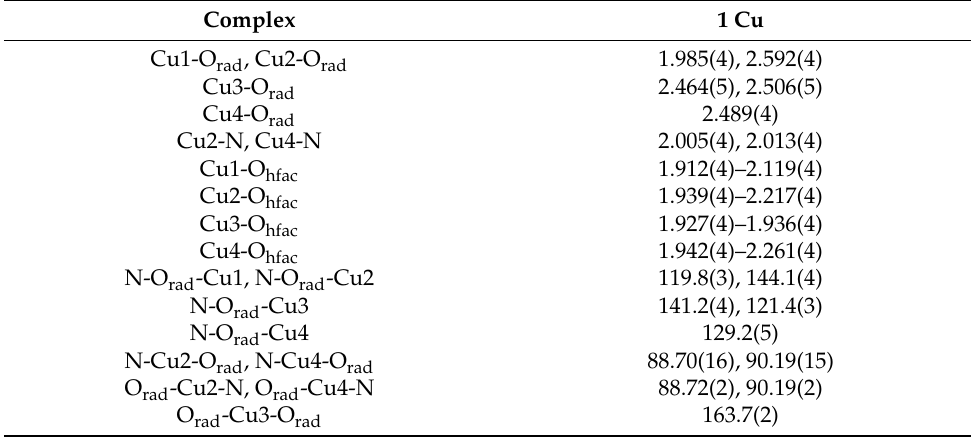
Table 3. Key bond lengths [Å] and angles [ ◦ ] for complex 1